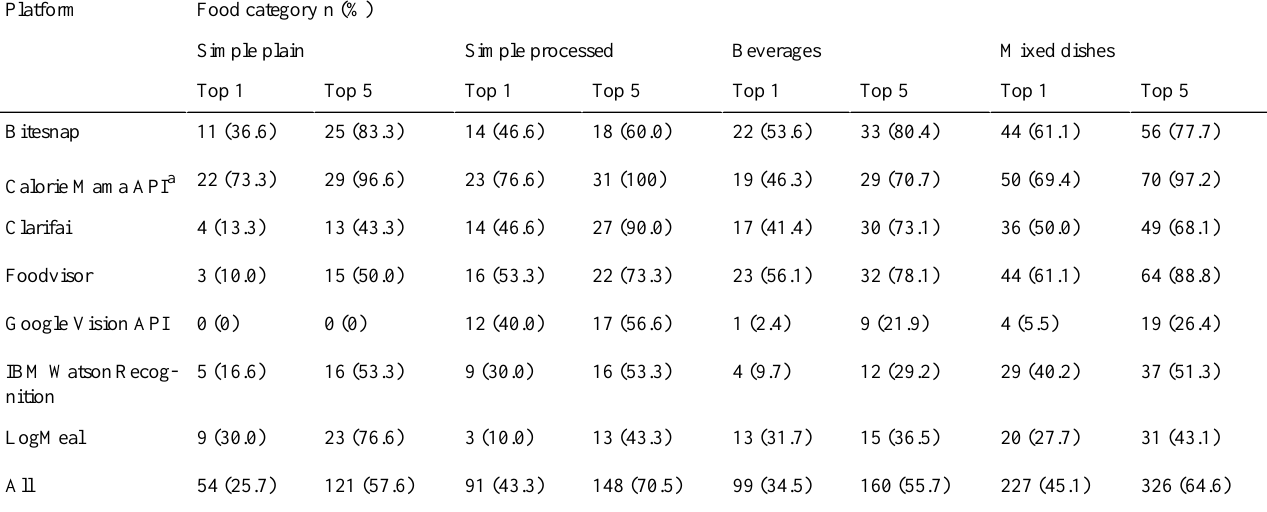
Table 4. Accuracy of image recognition among different food categories.